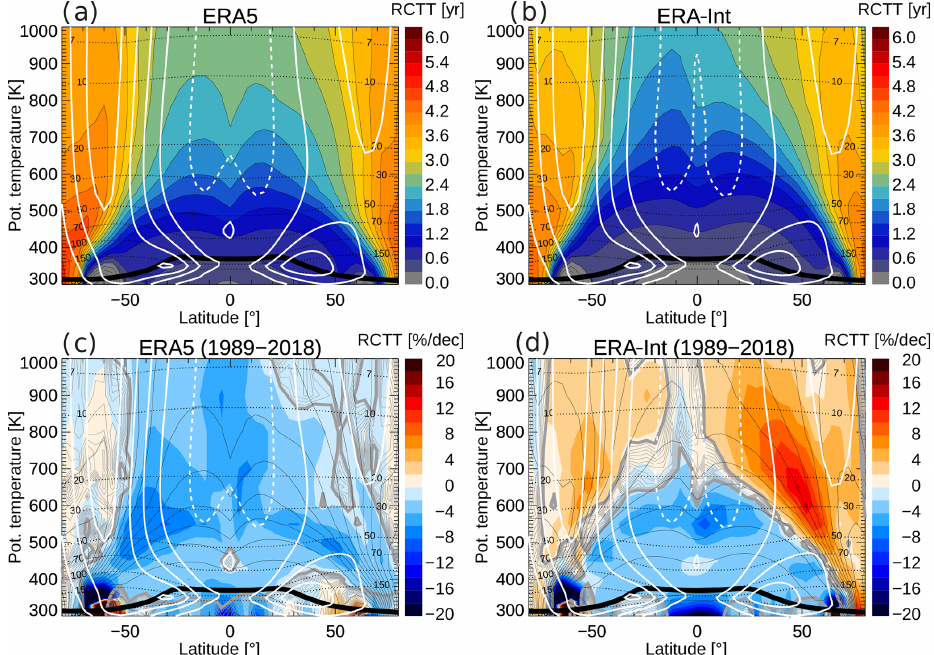
Figure 8. Residual circulation transit times (RCTTs) from ERA5 (a) and ERA-Interim (b) and their trends over the 1989–2018 period (c, d) . The thin black lines in panels (c) and (d) show climatological RCTT contours (in 0.3 year steps). The white contours show zonal wind (in ± 10m/s steps; easterly wind dashed), the thin dashed black lines show potential temperature levels, and the thick black line shows the (WMO lapse rate) tropopause. The significance of the linear trend, measured in multiples of the standard deviation σ , is shown as grey contours (the 2 σ contour is thick, and the contours then decrease with a 0.2 step – shown by thin